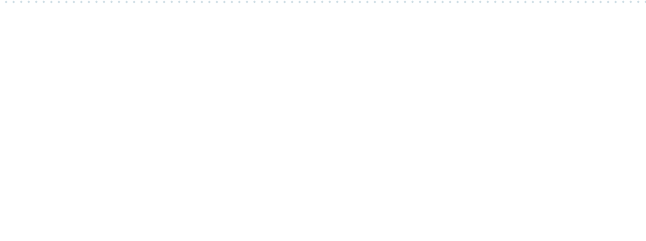
of the differences).